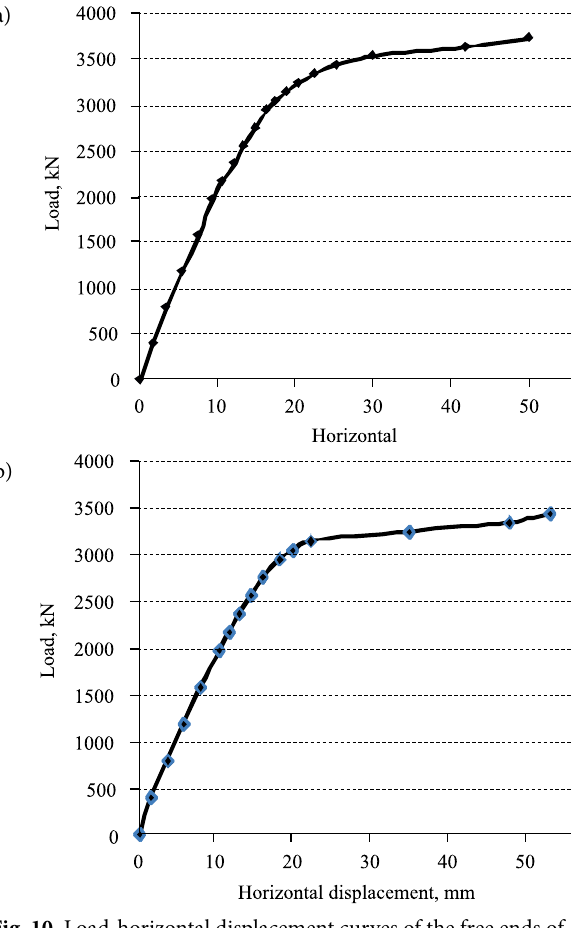
Fig. 10. Load-horizontal displacement curves of the free ends of chords: a – ZHJD-1; b – ZHJD-2